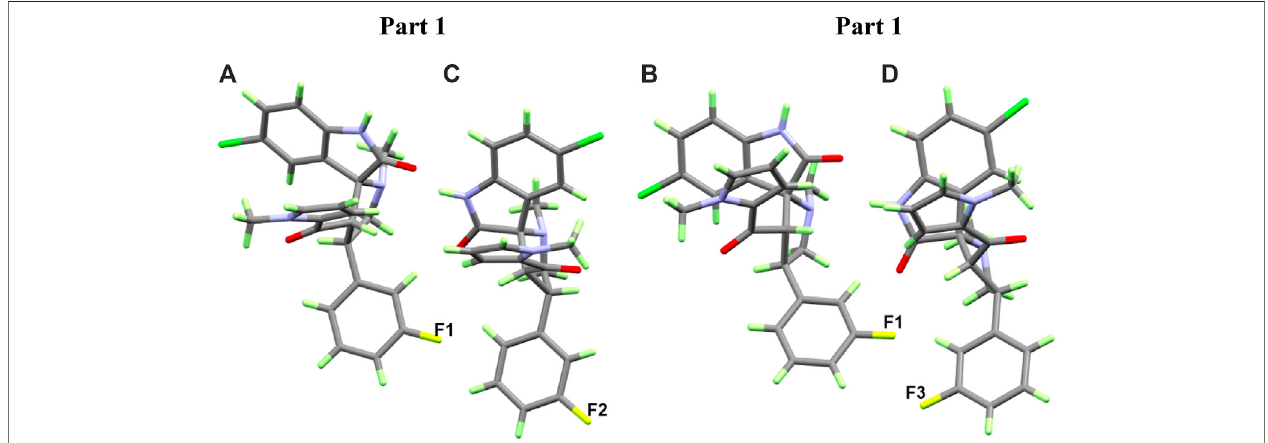
FIGURE 6 | The possible orientation of the two molecular units as a consequence of the substitutional disorder in 2a .